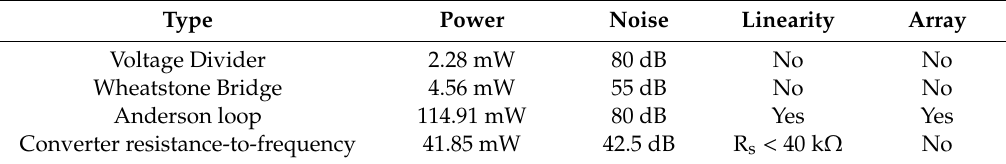
Table 1. Comparison of obtained data.